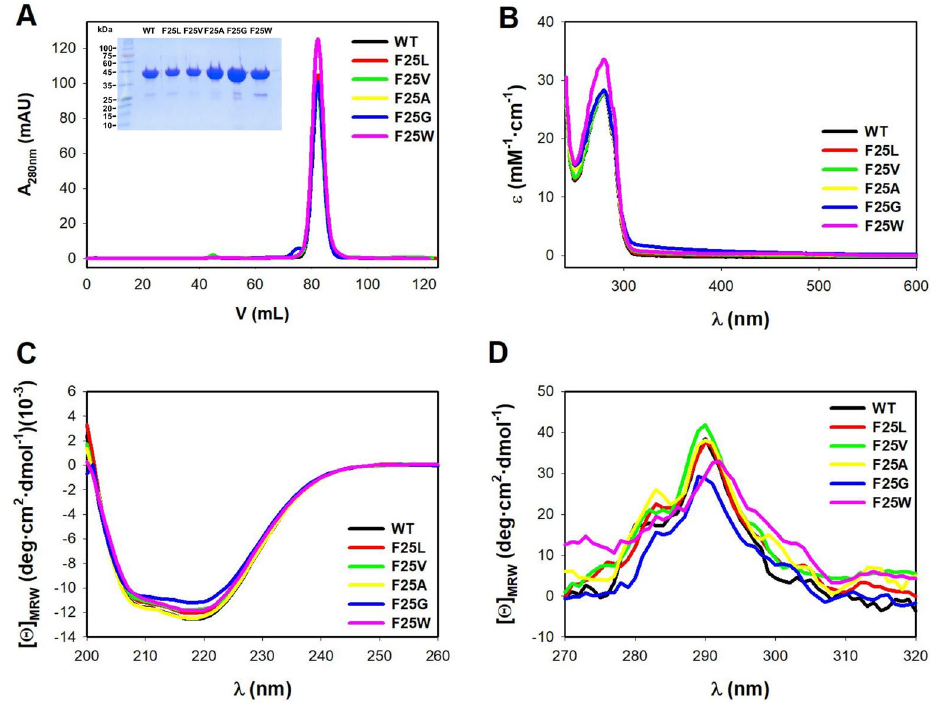
Figure 2. Purification and initial characterization of the conformation of hPGK1 variants. ( A ) SEC chromatograms of 4 mg of hPGK1 proteins purified from IMAC. The inset shows the corresponding SDS-PAGE (12% acrylamide) gel loaded with 5–10 µg of the protein purified from SEC. ( B ) UV–visible spectra of hPGK1 variants from absorption spectroscopy. Data were normalized considering the theoretical ε 280nm for each protein variant. ( C ) and ( D ) far-CD ( C ) and near-CD ( D ) spectra for each variant. Experiments in ( A ) and ( B ) were carried out in 20 mM HEPES–NaOH 200 mM NaCl, pH 7.4. In ( C ) and ( D ), experiments were performed in